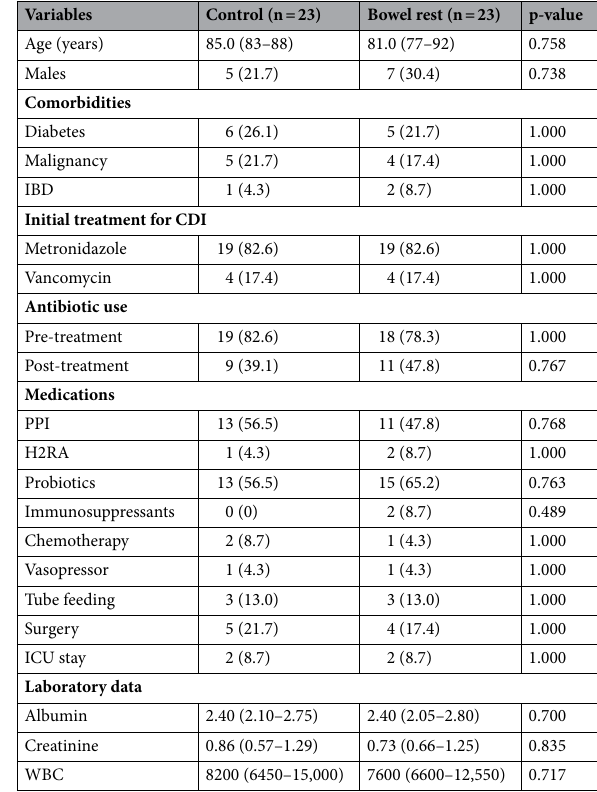
Table 2. Clinical characteristics in the propensity score-matched cohort. Data are median (interquartile range) or number (%). IBD , inflammatory bowel disease; CDI , Clostridioides difficile infection; PPI , proton pump inhibitor; H2RA , histamine H2-receptor antagonist; ICU , intensive care unit; WBC , white blood cell count.